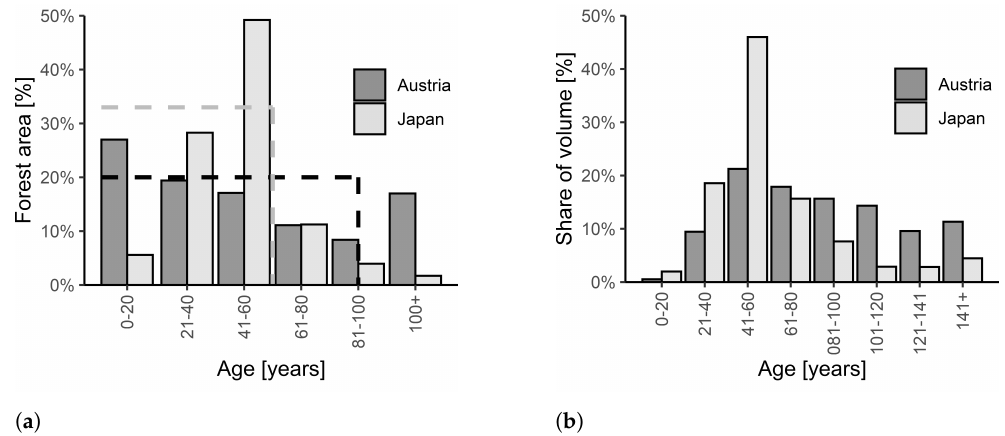
Figure 7. Percentage of forest area (planted forests and Ertragswald) according to age class ( a ) and the percentage of volume of all forests according to age class ( b ). Dotted lines in ( a ) show the perfect distribution for Cryptomeria japonica in Japan and Picea abies in Austria. Data are from the Austrian National Forest Inventory (2018) and Japanese National Forest Inventory